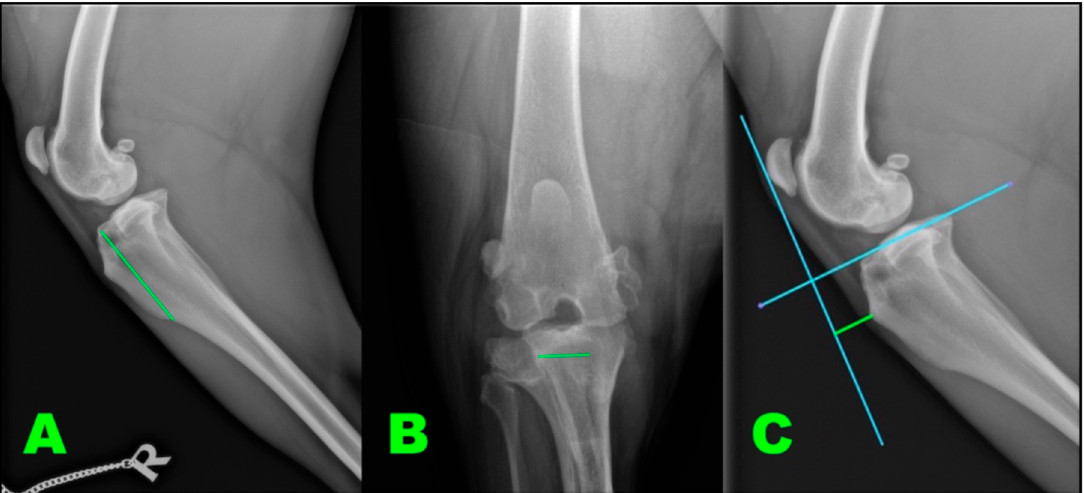
Figure 3. Measures taken to acquire implant conformation. We take three measures ( A – C ) corresponding to the green in the images. ( A ) Implant length; ( B ) implant width; ( C ) implant depth.